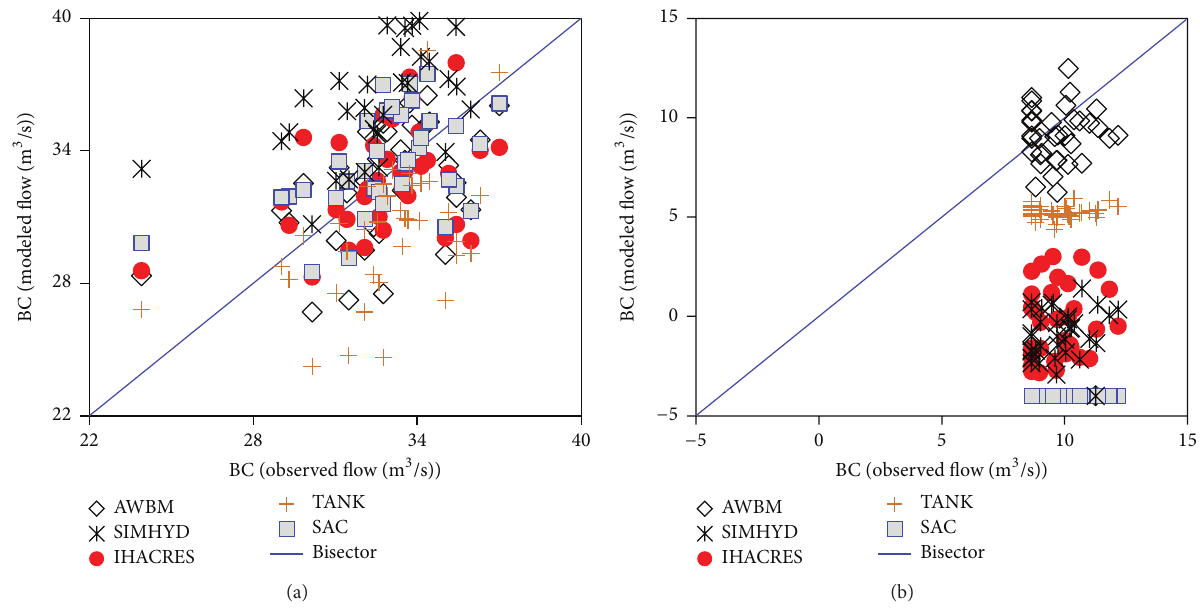
Figure 9: Model performance evaluation for (a) maximum flow in a year and (b) minimum flow in a year. For the labels of the axes, “BC” appearing before “()” shows that the flow (m 3 /s) values plotted were obtained after applying Box-Cox (BC) transformation using (5).